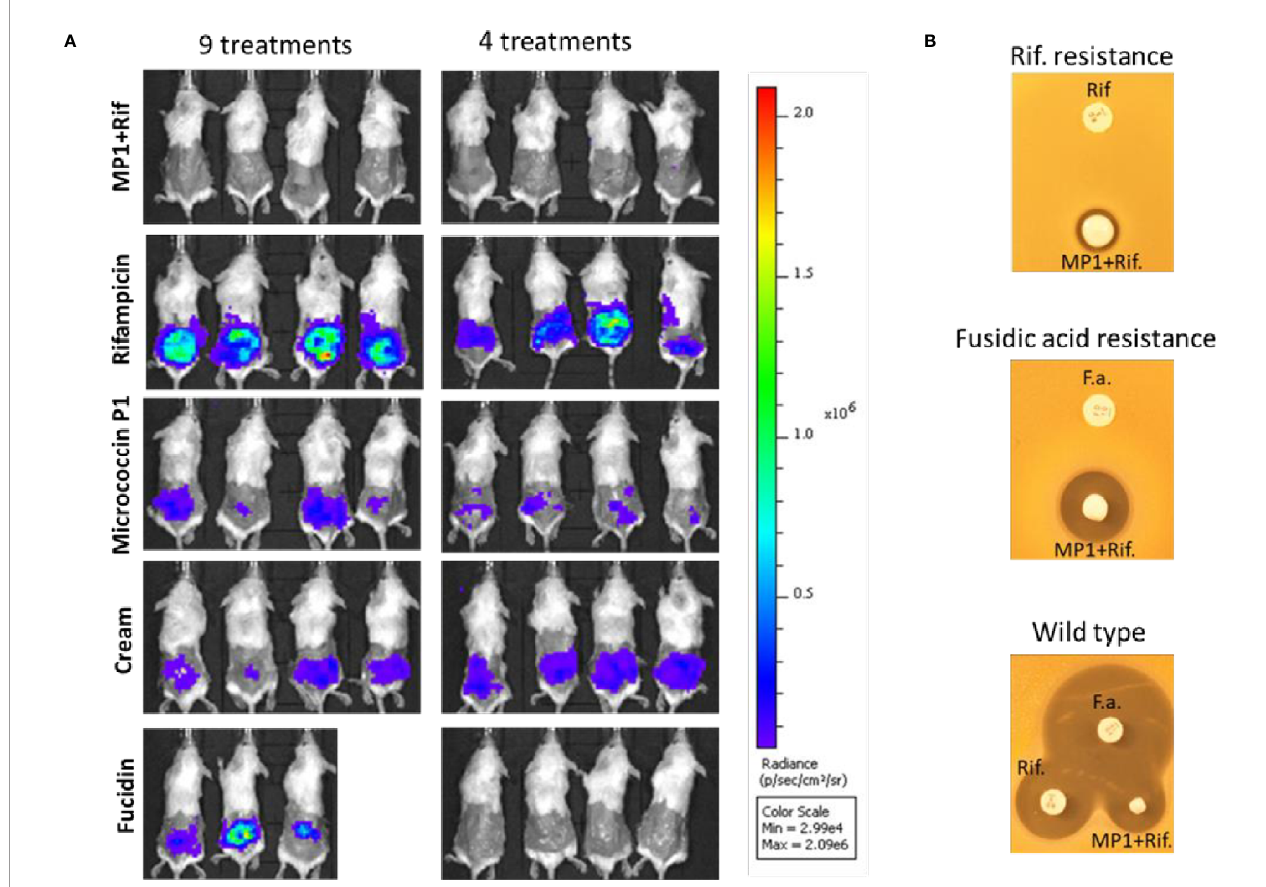
FIGURE 5 | (A) In vivo images of bioluminescent signals produced by MRSA Xen31(in photons/second/cm 2 /steradian) from the different mouse groups on the last day of the experiment; left column: with nine daily treatments; right column with four daily treatments. (B) Rifampicin and fucidin resistance develops during the treatment of mice. Rifampicin resistant cells (Rif-resistance) and fucidic acid resistant cells (Fucidic acid resistance) isolated from the wounds with strong bioluminescent signals were rechallenged and shown to be resistant to rifampicin (Rif) and fusidic acid (F.a.) but not to the MP1-rifampicin mixture. Wildtype MRSA Xen31 cells exposed to the MP1-ripamicin mixture, rifampicin and fusidic acid were sensitive to all three